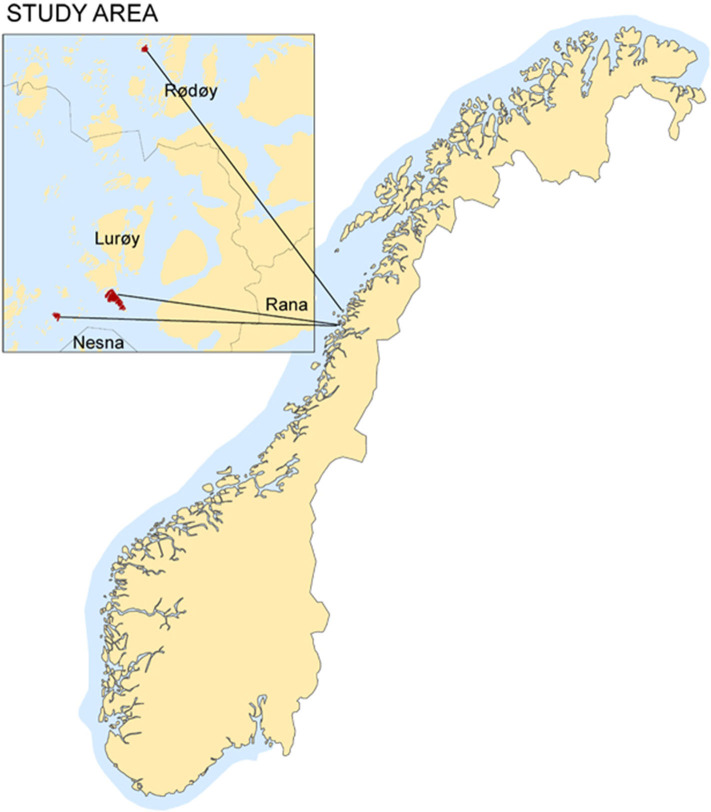
Map of Norway and the islands (insert) Sandvær (south), Sjonøya and Buøya (north).